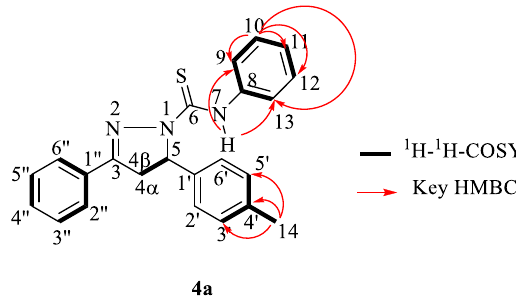
Figure 2. Key COSY/HMBC correlations of compound 4a .